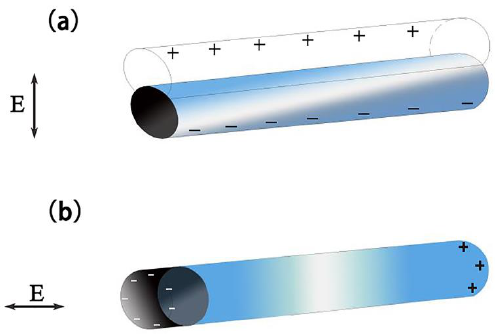
Figure 6. Schematic of two types of LSPR of metallic nanorods: ( a ) LSPR T ; and ( b ) LSPR L.